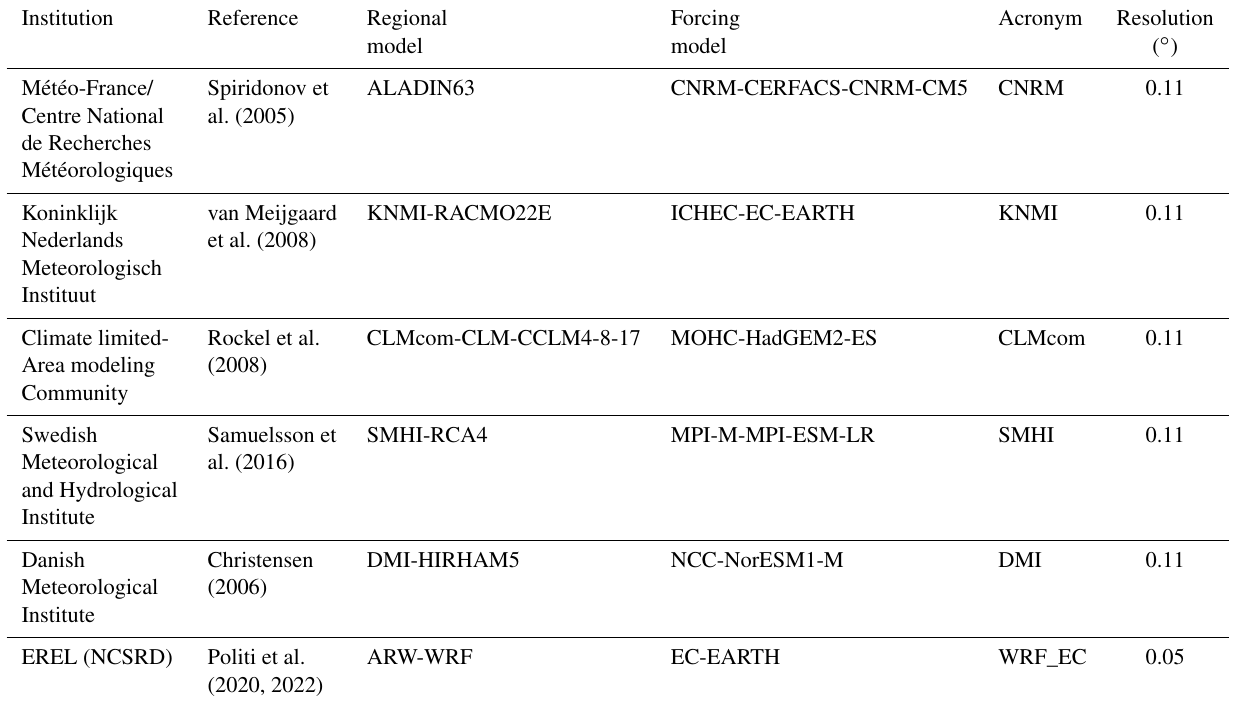
Figure 1. Map of HNMS stations on orography of (a) ERA5 and (b) WRF-ERA-Interim. The numbers correspond to those in Table A1. Table 1. EURO-CORDEX and EREL-NCSRD simulation models